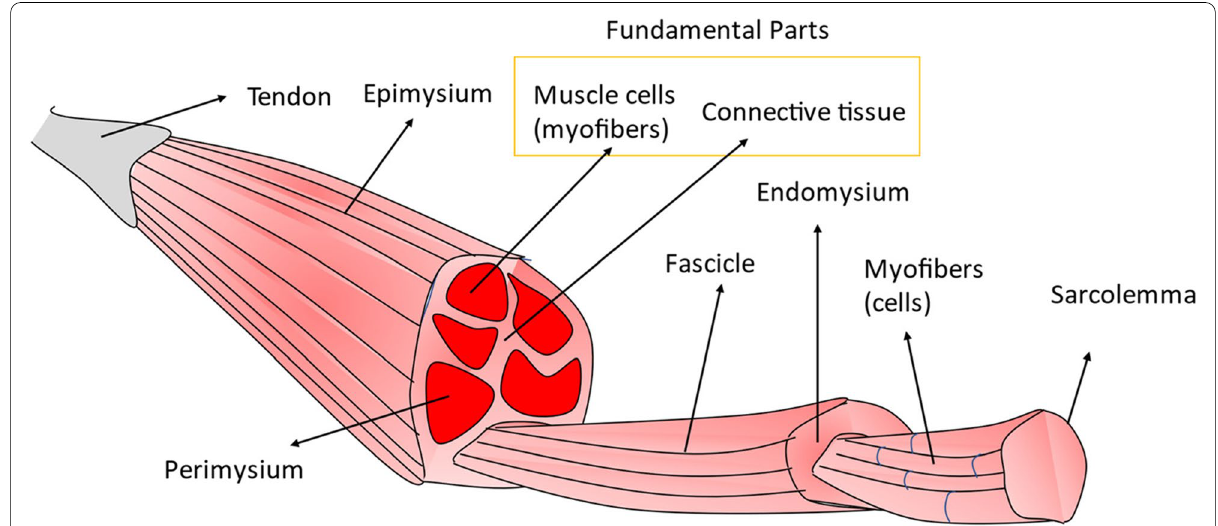
Fig. 1 Skeletal muscle anatomy comprises two fundamental parts: myofibres and connective